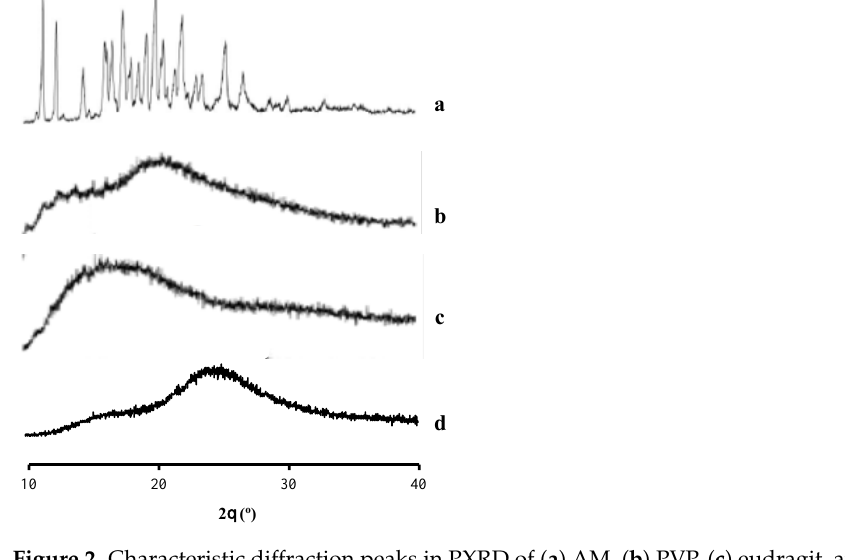
Figure 2. Characteristic diffraction peaks in PXRD of ( a ) AM, ( b ) PVP, ( c ) eudragit, and ( d ) HPMC.